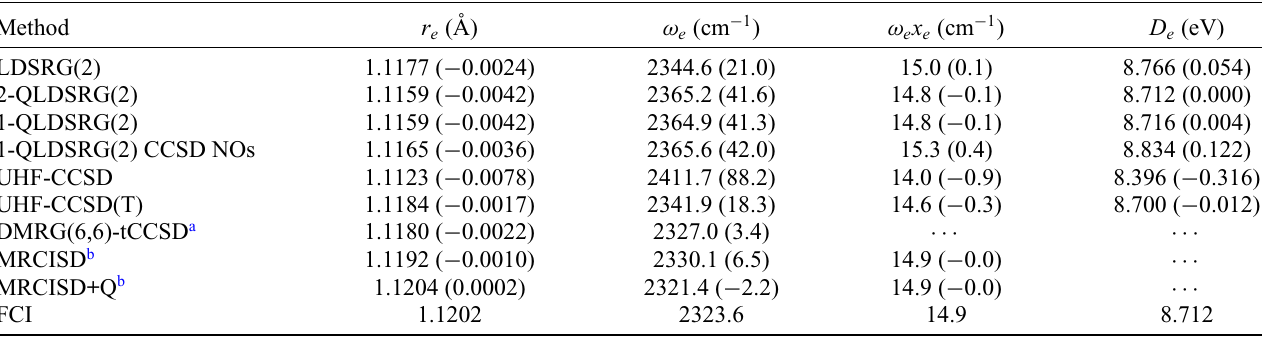
TABLE II. Spectroscopic constants for the ground state ( X 1 (cid:12) + show deviations from FCI results. All LDSRG(2) and QLDSRG(2) computations as well as the literature results listed here use the cc-pVDZ